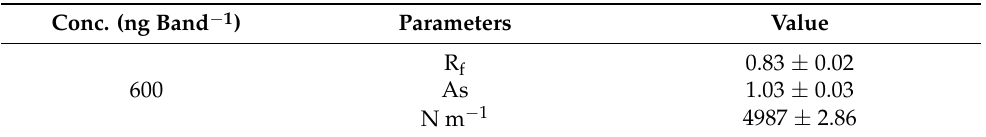
Table 2. System efficiency parameters including retardation factor (R f ), asymmetry/tailing factor (As), and number of theoretical plates per meter (N m − 1 ) of HDQ determined at MCQ (600 ng band − 1 ) for ecologically sustainable HPTLC method (mean ± SD; n = 3).